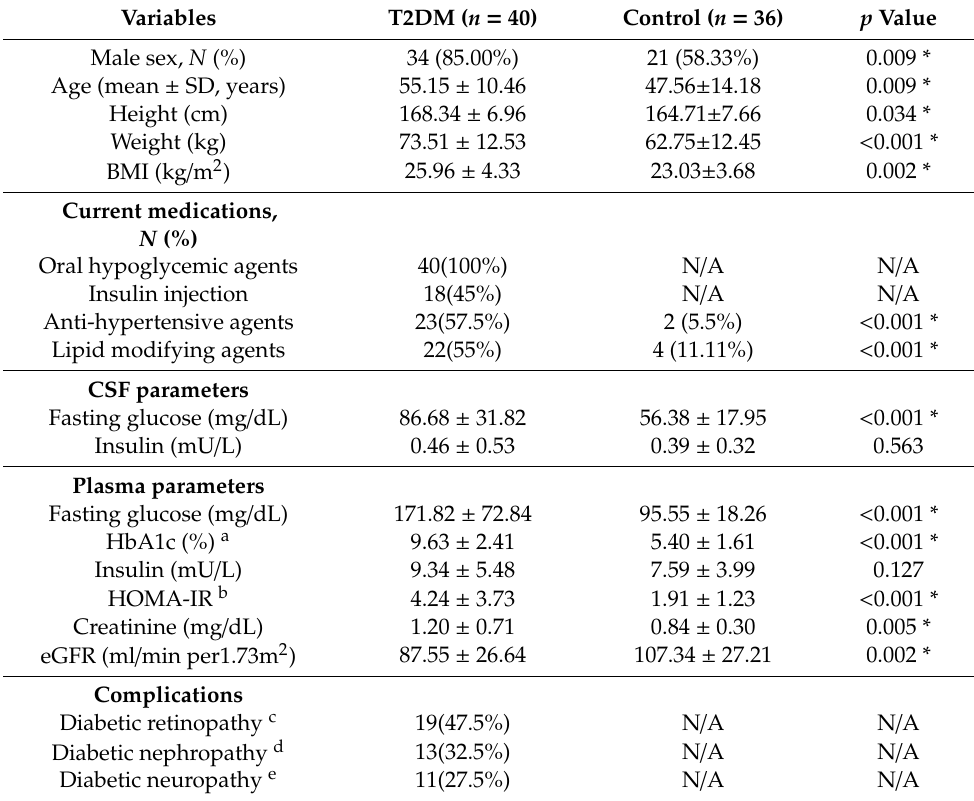
Table 1. Demographic characteristics and laboratory parameters in cerebrospinal fluid (CSF) and plasma samples from type 2 diabetes patients and control